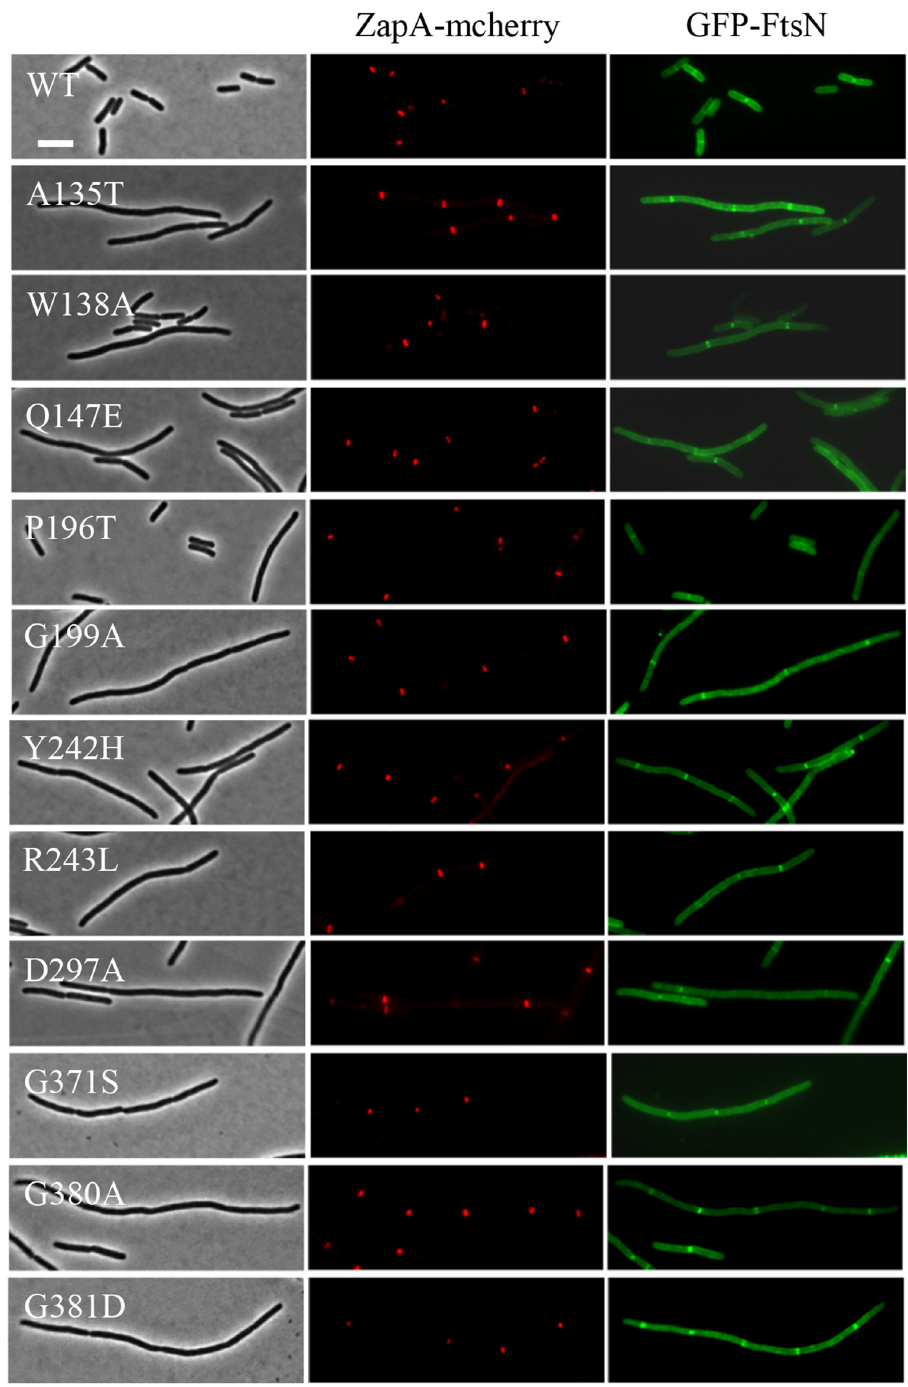
Fig 7. Overexpression of the dominant-negative FtsW mutants does not prevent localization of GFP-FtsN. The test was performed as in Fig 6 except plasmid pLY103 (pBAD33, P BAD: : gfp-ftsN ) was used instead of pLY114. Scale bar, 3 μ